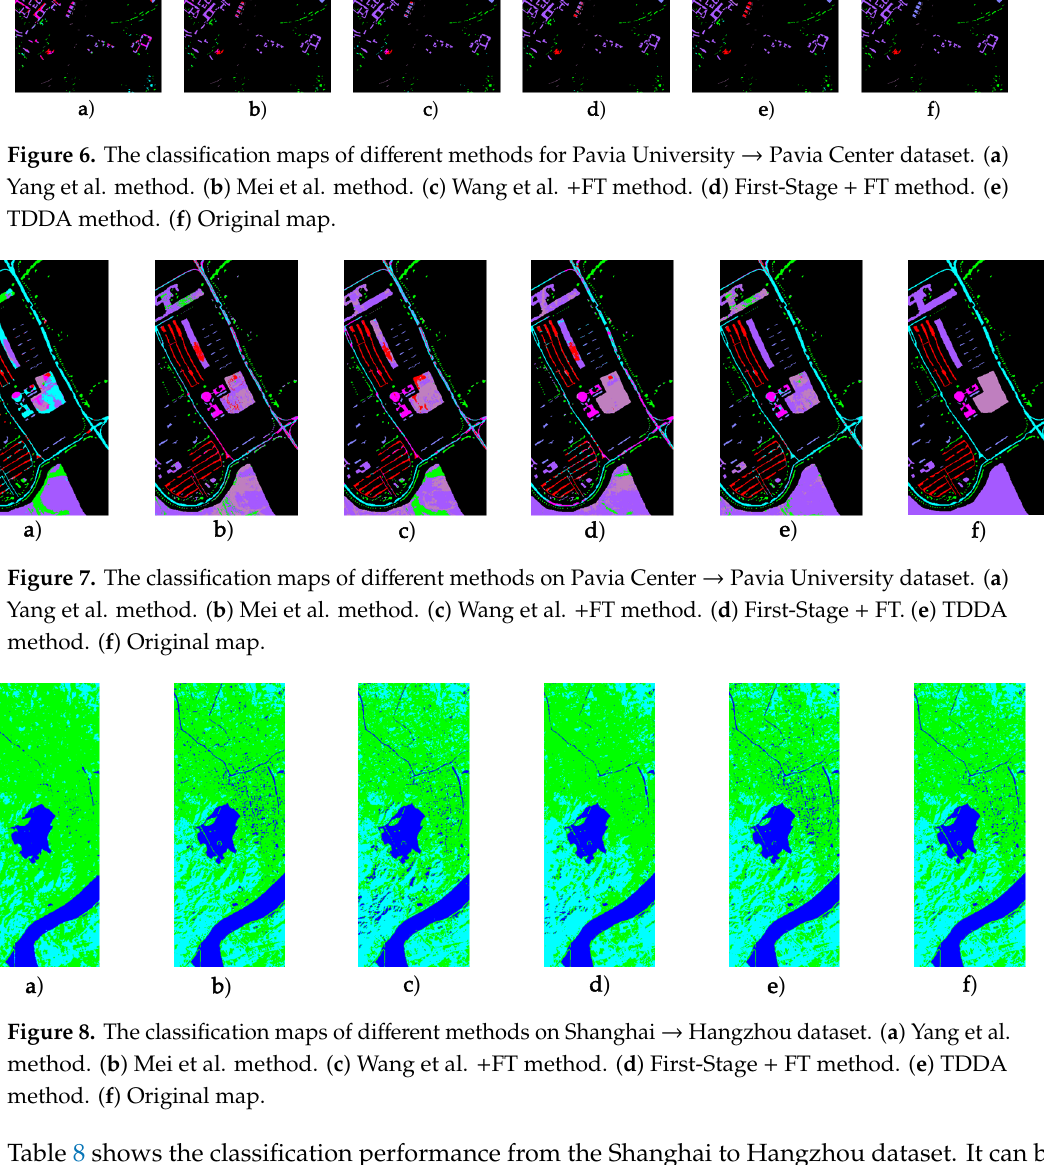
Figure 8. The classification maps of different methods on Shanghai → Hangzhou dataset. (a) Yang et al. method. (b) Mei et al. method. (c) Wang et al. +FT method. (d) First-Stage + FT method. (e) TDDA method. (f) Original map.